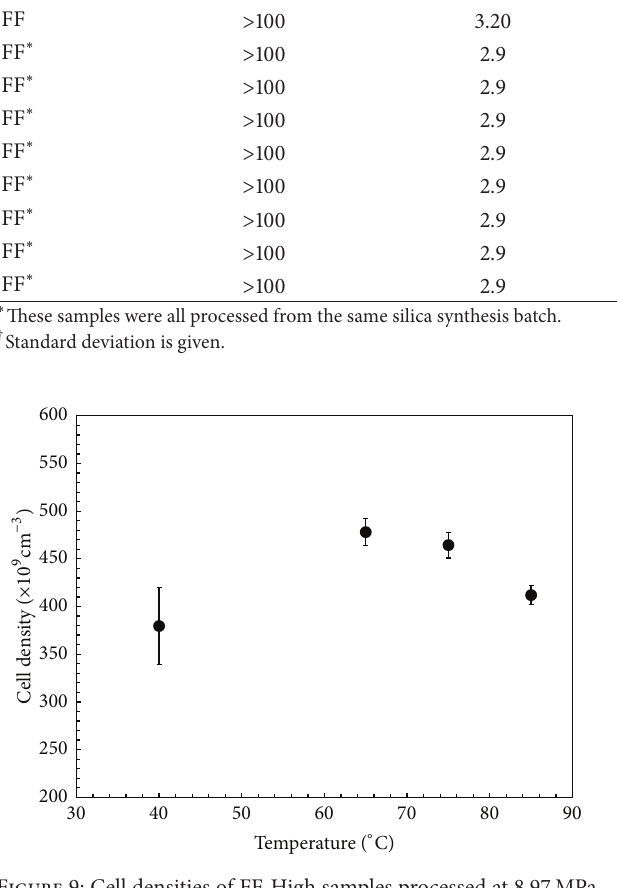
Figure 9: Cell densities of FF-High samples processed at 8.97 MPa as a function of saturation temperature. Error bars are the standard error for five samples.